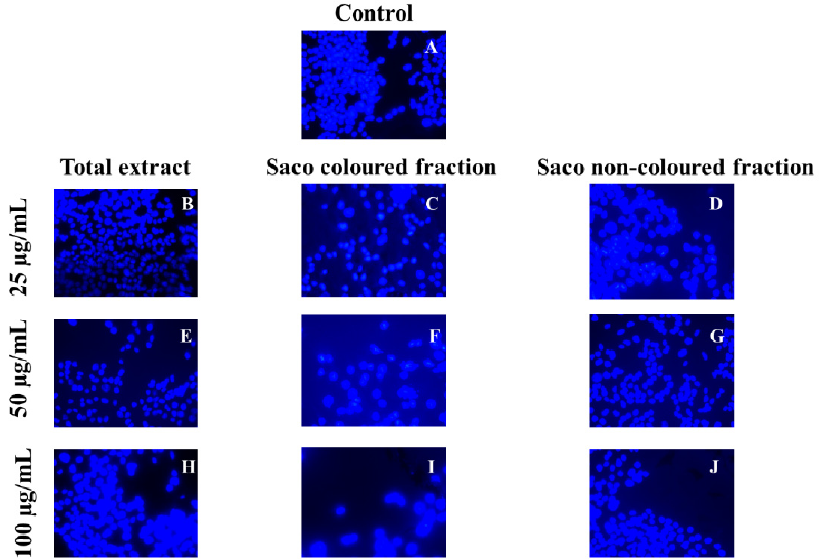
Figure 4. Nuclear morphological study by 4 ′ ,6-diamidine-2 ′ -phenylindole dihydrochloride staining of HepG2 cells (control vs. treatment after 72 h of incubation). ( A ) corresponds to the control, ( B , E , H ) correspond to Saco total extract, while ( C , F , I ) to the coloured fraction and ( D , G , J ) to the non-coloured one, at concentrations of 25, 50 and 100 µg/mL, respectively. Three independent experiments were performed, and a representative field was selected.